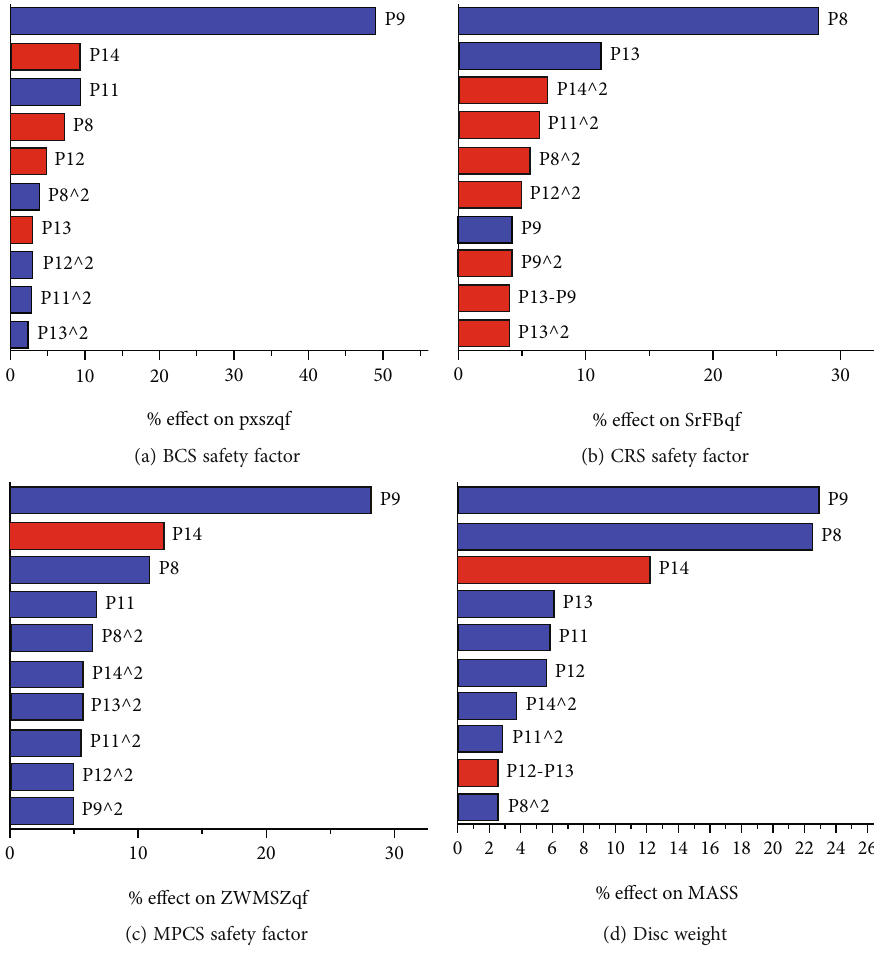
Figure 3: Pareto